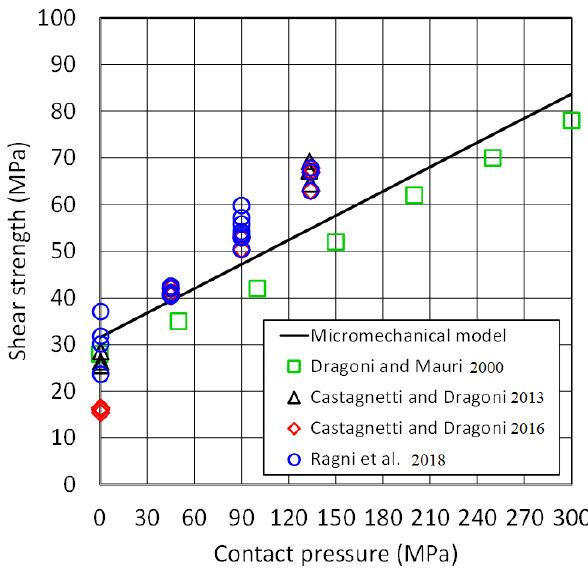
Figure 8. Comparison between the computational model prediction and experimental data from the literature [1,40,42,43] for the Loctite 638 adhesive.